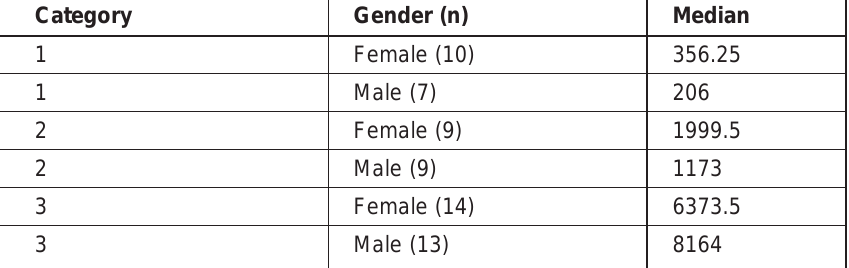
Table 2: Kruskal-Wallis non-parametic ANOVA